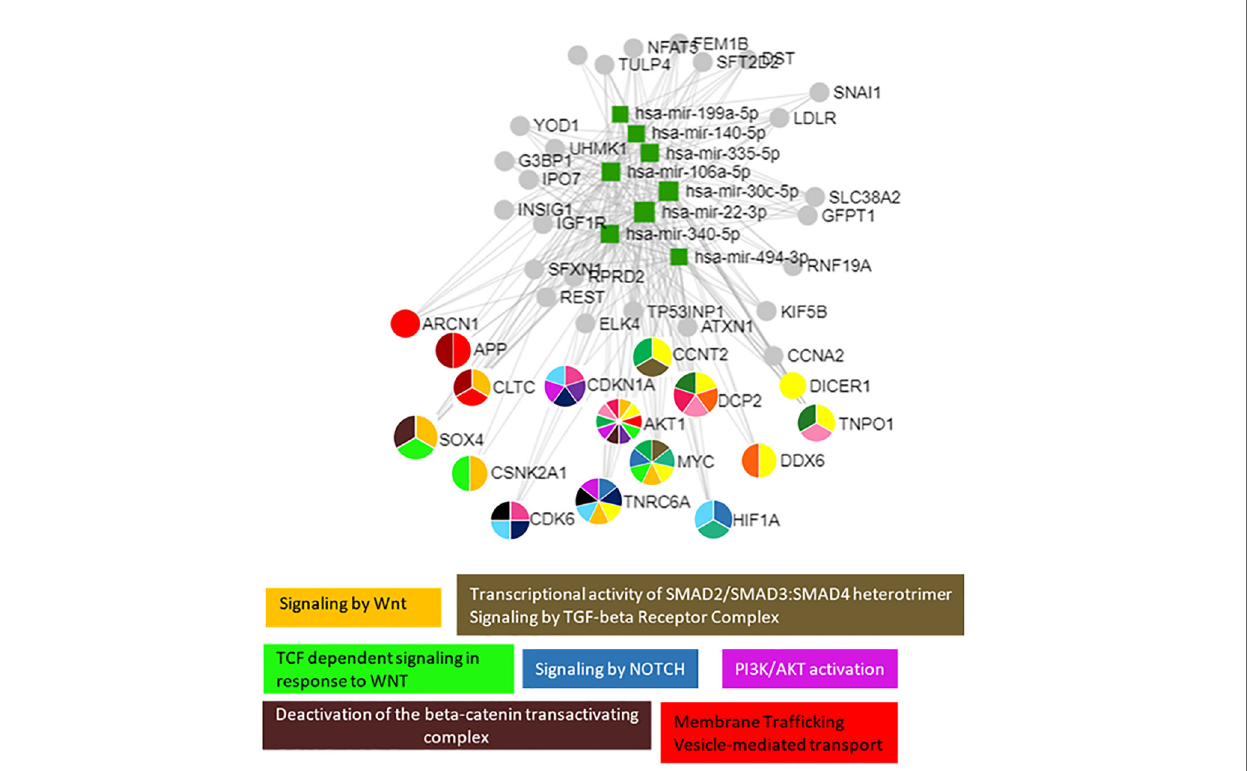
FIGURE 3 | The 8 selected miRNAs regulated genes and pathways that are important for growth. Analyses were carried out using miRNet v 2.0 and only signi fi cantly predicted pathways ( p < 0.05) were selected to generate the fi